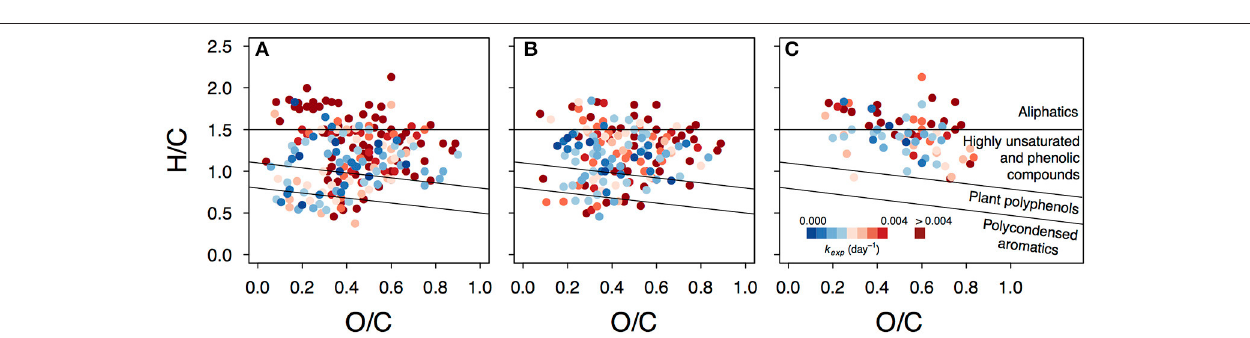
FIGURE 6 | Van Krevelen plots depicting variability in decay rates of photoproduced compounds. Presented are data from lake Lumpen (A) , Ramsjön (B) and Övre Langsjön (C) . One of the experimental duplicates is shown in each case (data from the second duplicate is shown in the Figure S10).